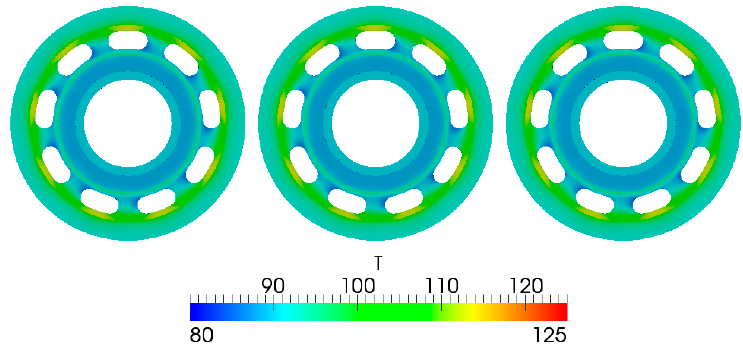
Figure 21. Cylinder block temperature distribution comparison for different sizes.